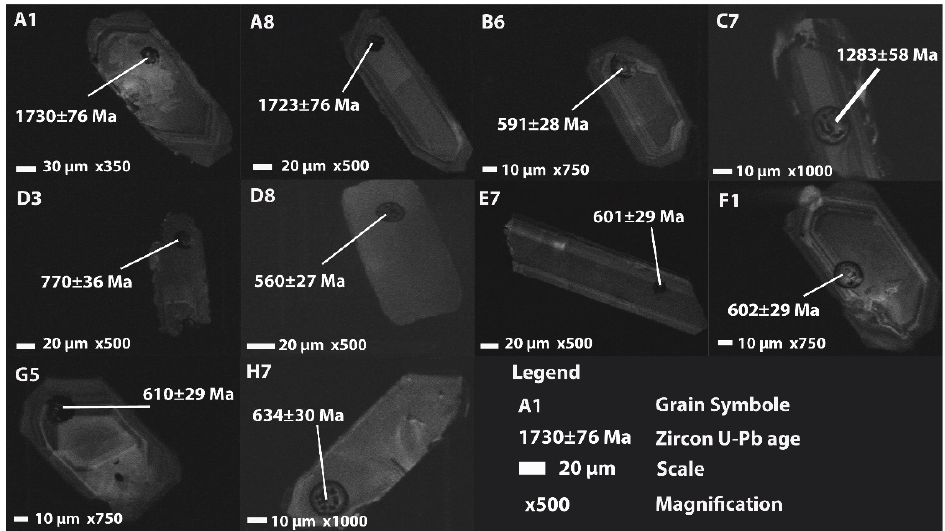
Figure 4. Cathodoluminescence (CL) images showing the location of analysis spots and their 206 Pb/ 238 U weighted mean ages for some of the analyzed zircon grains.